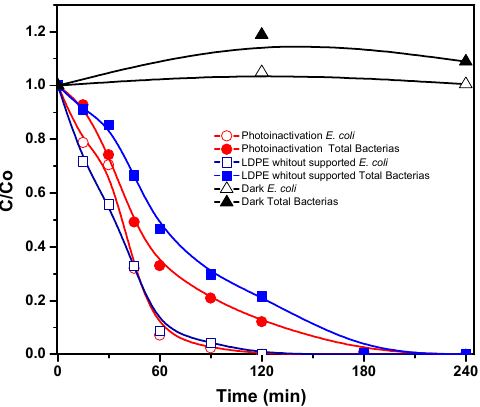
Figure 7. Inactivation of total bacteria and E. coli in dark and under sunlight (photoinactivation and mechanical stress caused by agitation of LDPE pellets).